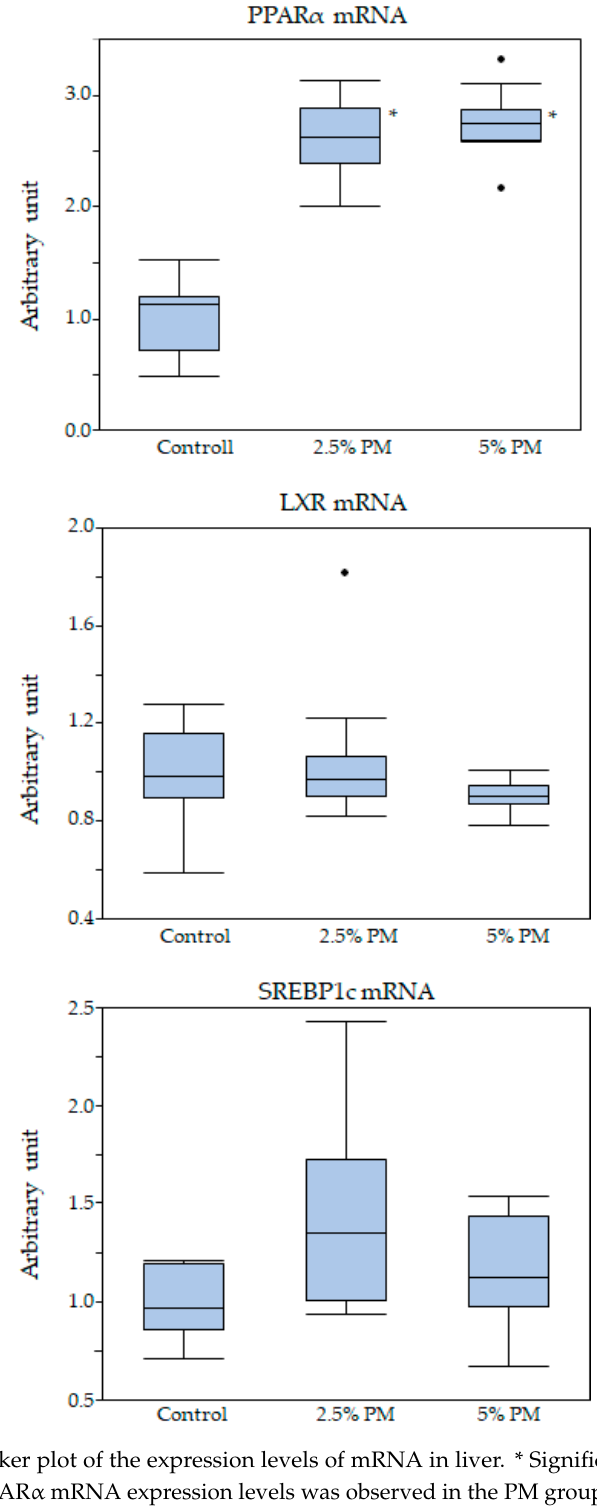
Figure 2. Box-whisker plot of the expression levels of mRNA in liver. * Significant dose dependent up-regulation of PPAR α mRNA expression levels was observed in the PM groups ( p < 0.05).